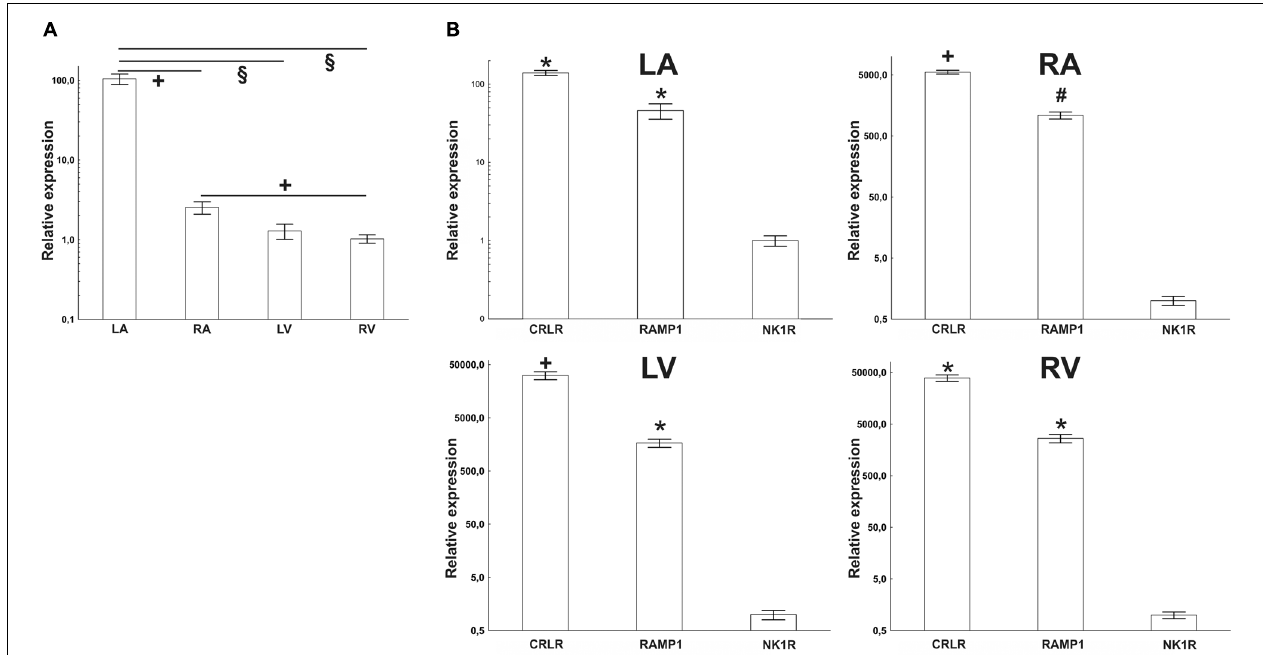
FIGURE 1 | (A) RT-PCR quantification of NK1 receptor mRNAs in heart compartments (left atrium – LA, right atrium – RA, left ventricle – LV, and right ventricle – RV) of rats. Mean value from RV was used as a calibrator, when delta Cq value of this group was set as “1.” (B) Quantification of sensory receptors mRNAs by RT-PCR in heart compartments of rats; left atrium (LA), right atrium (RA), left ventricle (LV), and right ventricle (RV). Mean values of NK1 receptor (NK1R) expression were used as a calibrator. Expression of calcitonin receptor-like receptor (CRLR) and receptor activity modifying protein 1 (RAMP1) was compared to it. The difference is smallest in the LA and biggest in the RV. Data are presented as a relative expression ± SEM. § p < 0.0001, + p < 0.05, # p < 0.01, and ∗ p < 0.005 (Mann–Whitney test) compared to corresponding heart compartment (in A ) or compared to expression of NK1R (in B ). N = 4–6 in each group.